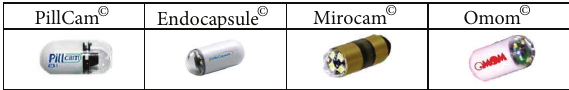
Figure 1: Illustration of the existing WCE